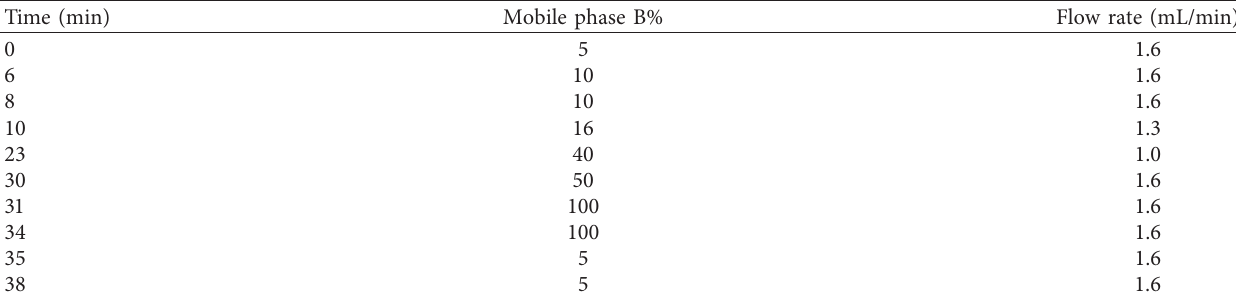
Table 1: The elution gradient and flow